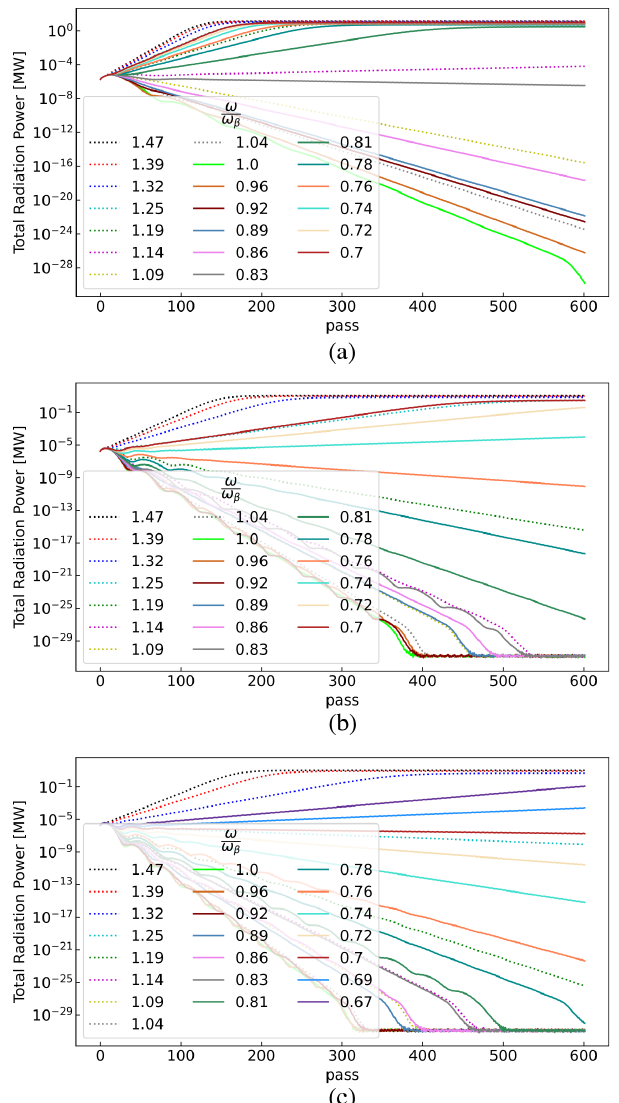
FIG. 12. Power evolution in XFELO-A with R ¼ 0 . 8 ð ˆ q ¼ 4 Þ subject to periodic misalignments with frequencies between 0.67 and 1.46 times the Betatron frequency with the crystal tilt amplitude of (a) 45 nrad, (b) 67.5 nrad, and (c) 78.75 nrad. The y -axis scale is log 10